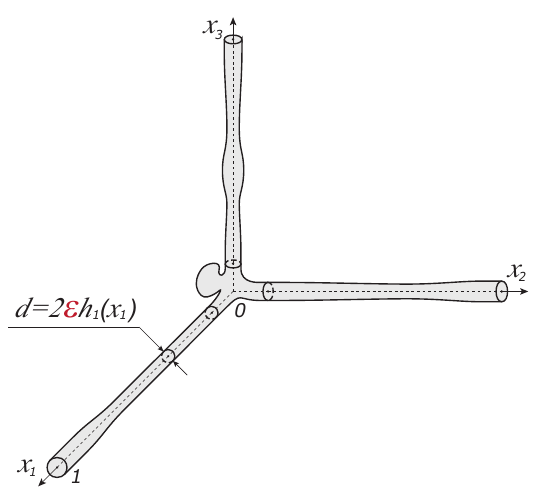
Fig. 2. The model thin aneurysm-type domain (cid:127)